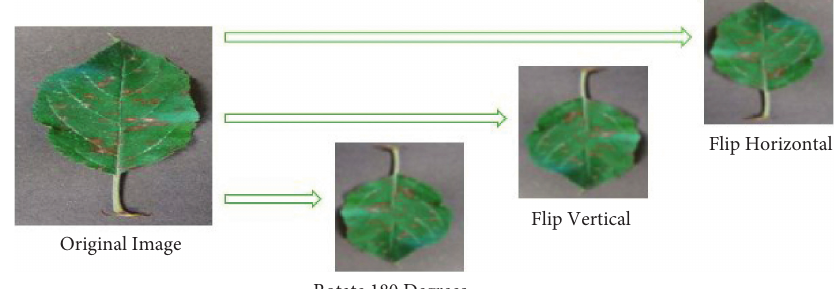
Figure 6: Geometry